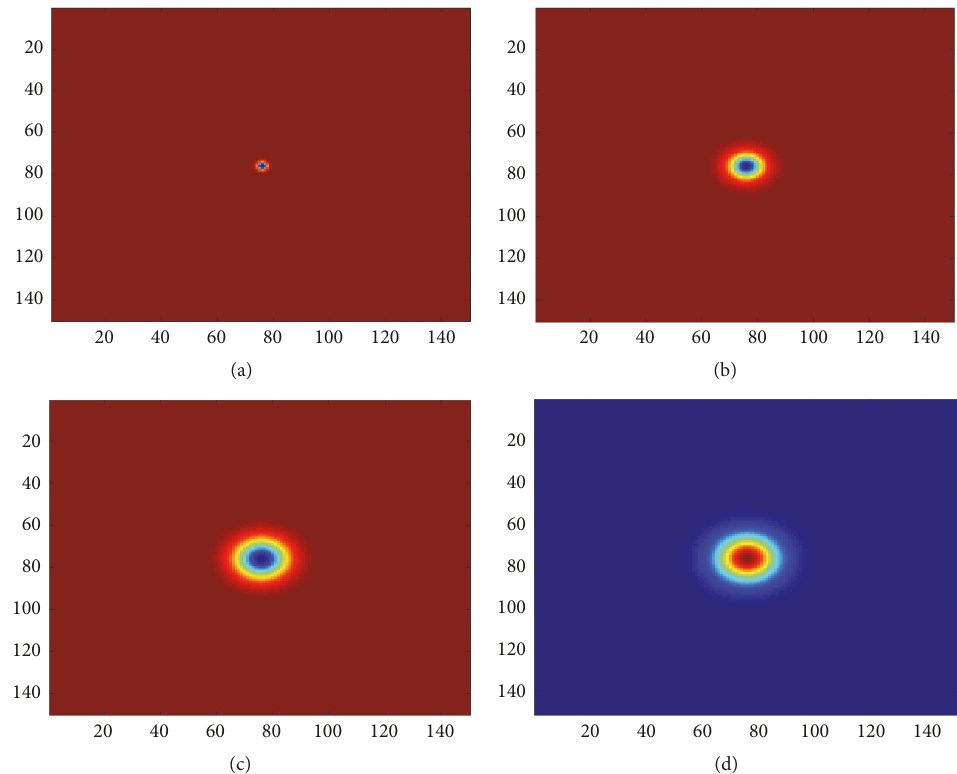
Figure 11: The snapshots of spatial distribution of membrane potential with color scale for neurons in the square array network for 𝑘 = 1 and 𝐷 = 1 at (a) 𝑡 = 2 time units, (b) 𝑡 = 75 time units, (c) 𝑡 = 170 time units, and (d) 𝑡 = 300 time units.